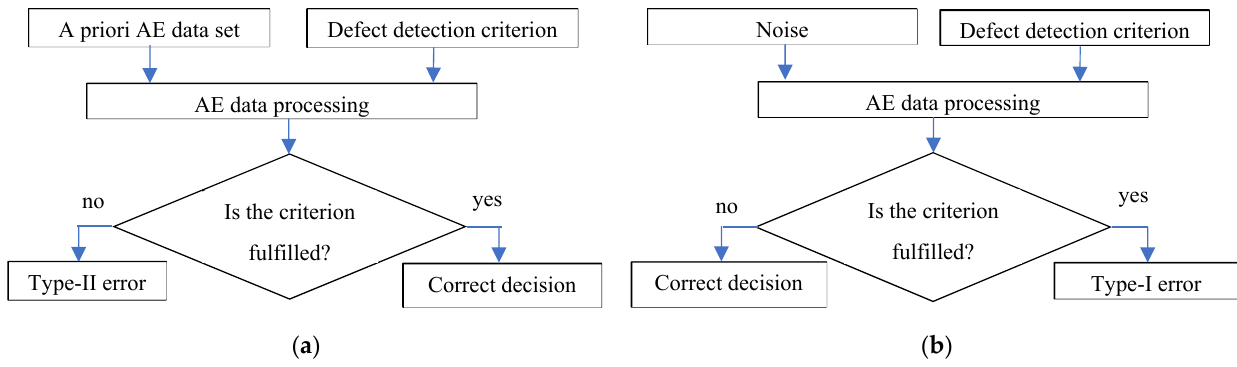
Figure 2. Simplified algorithms for estimating the probability of making a type I ( a ) and type II ( b ) errors.